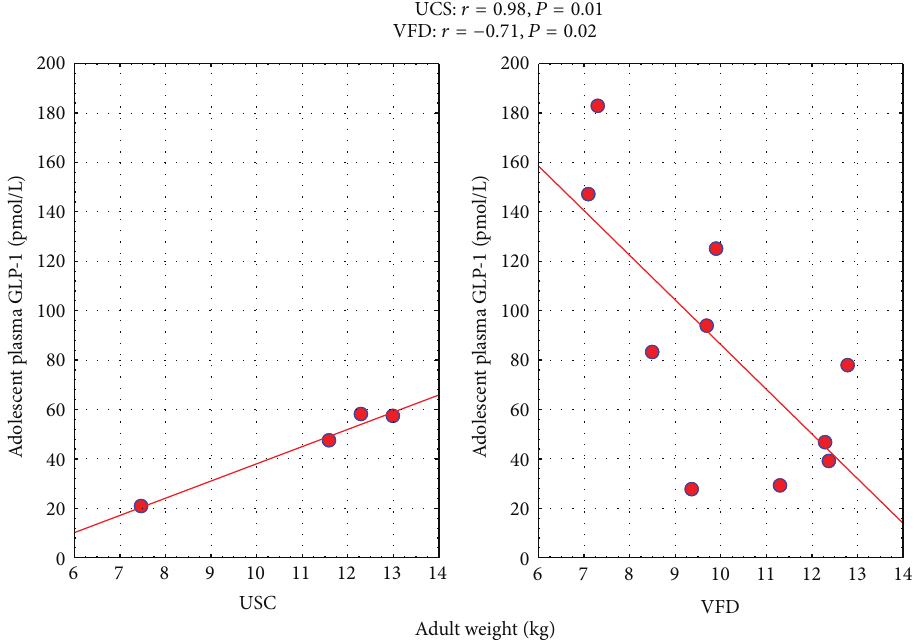
Figure 4: Relationship of adolescent pGLP-1 to adult body mass as a function of early life stress. Adolescent pGLP-1 was inversely associated with adult body mass in VFD but positively associated with adult body mass in non-VFD, leading to a significant difference in the “ 𝑟 ” value. GLM revealed a significant rearing group ∗ adult body mass interaction in the prediction of pGLP-1 [ 𝐹 (1,10) = 6.29 ; 𝑃 = 0.031 ] whereas, when adjusting for adult body mass, pGLP-1 concentrations were significantly increased in VFD versus non-VFD subjects [VFD mean (SE) = 85.00 (11.13) versus non-VFD mean (SE) = 45.68 (17.60); 𝐹(1,10) = 7.41 ; 𝑃 = 0.021